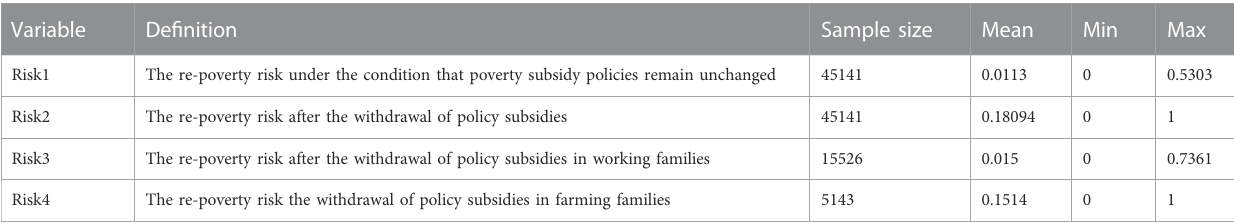
TABLE 2 Results of re-poverty risk